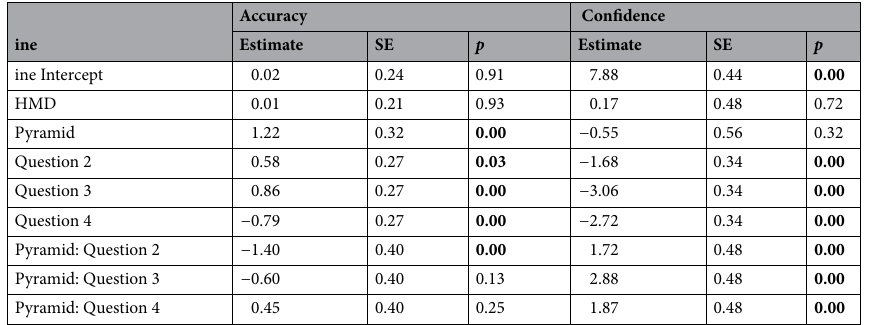
Table 1. Linear mixed-effects models for Accuracy and Confidence in Recall of the Scene Understanding Task. Each dependent measure is modelled as a function of the predictors: Learning Condition (with DT as reference category), type of model (with Liver as the reference category), Question (with Question 1 as a reference category) and their interaction. For each fixed effects and interaction, we report the coefficient and its standard error, along with the associated p -value. Statistically significant predictors (at the α = .05 level) are in